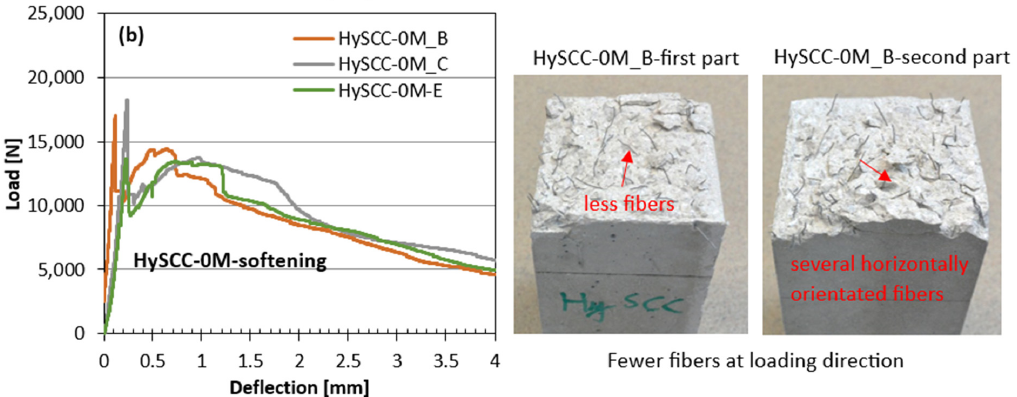
Figure 4. Load–deflection curves for HySCC-0M, where orientation of added steel fibers influences on the ( a ) hardening or/and ( b ) softening straining behaviors.